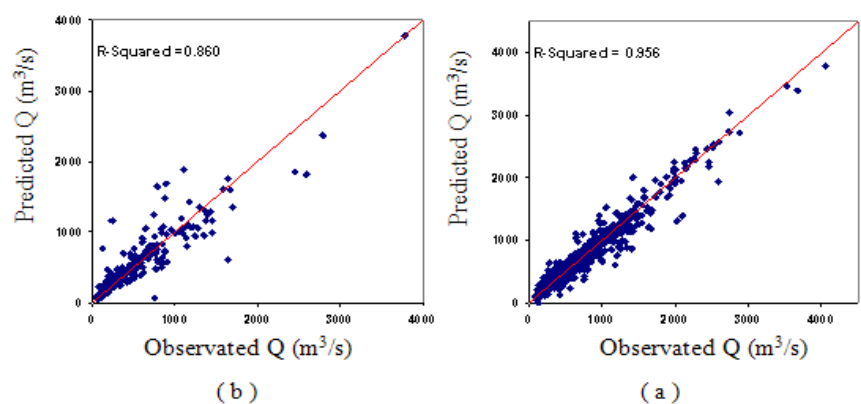
Fig. 8 Observed discharge versus predicted discharge for model 5: a) training data, b) testing data